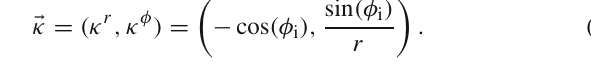
culated by numerically solving the orbital equation (dashed black lines) for different initial emission angles. In order to measure the convergence of our approach, we plot the angular deviation , (cid:14)θ , measuring the absolute angular error